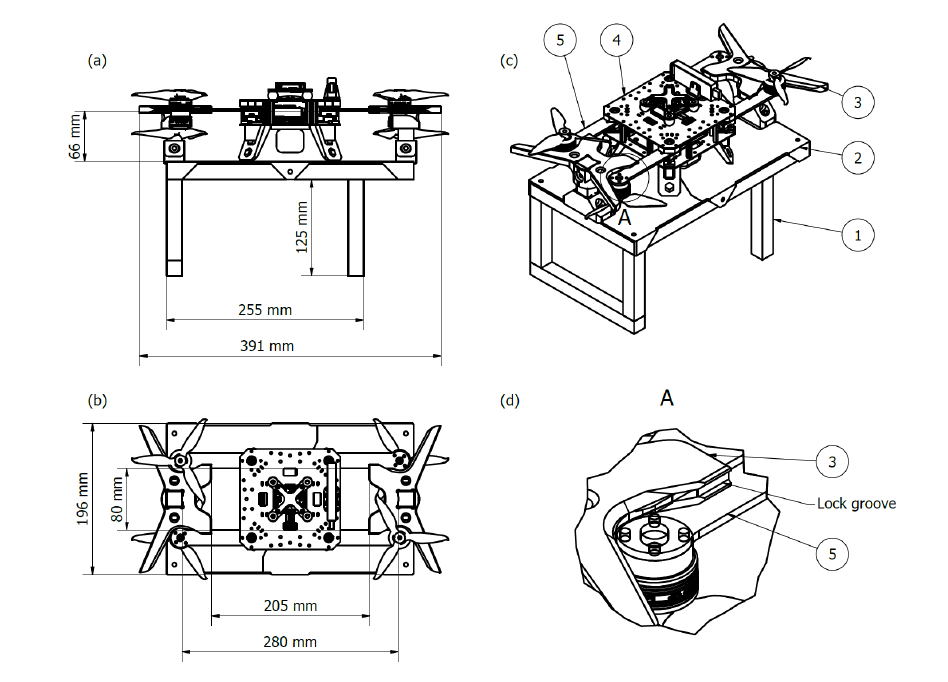
Figure 4. Schematics including the basic dimensions of the landing platform with the R-shafter drone. Presented in the H configuration ( a , b ) and locked in place ( d ). Overview of the components ( c ): 1—aluminium profile platform frame, 2—3D printed landing desk, 3—drone aligner, 4—R-Shafter body, 5—R-Shafter arm.